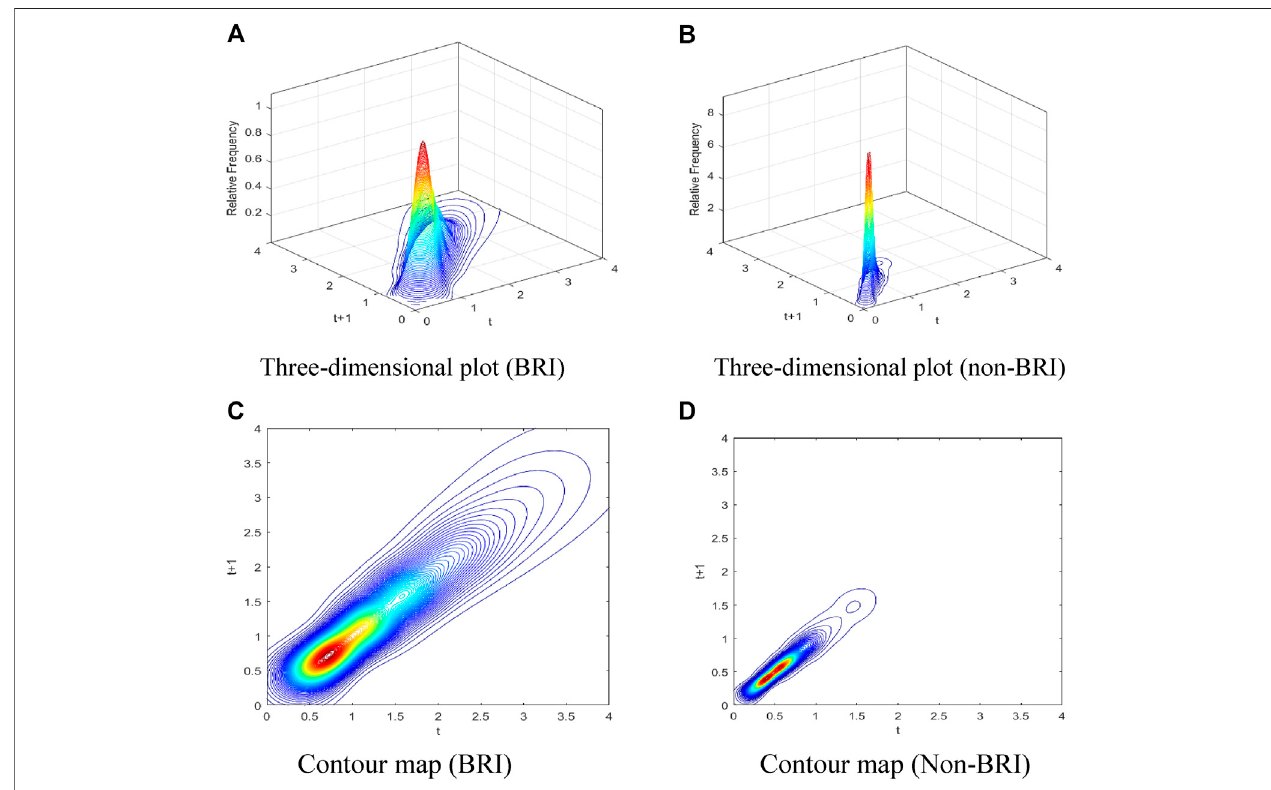
FIGURE 1 | Three-dimensional plot and Contour map of transitional probability kernel for carbon emission per GDP with yearly transitions, from 1987 to 2014. (A) Three-dimensional plot (BRI). (B) Three-dimensional plot (non-BRI). (C) Contour map (BRI). (D) Contour map (Non-BRI).